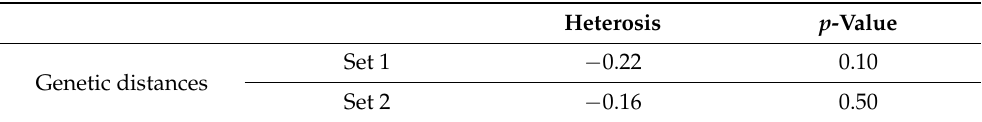
Table 9. Correlations between heterosis of market yield and genetic distances of the parents for both sets of